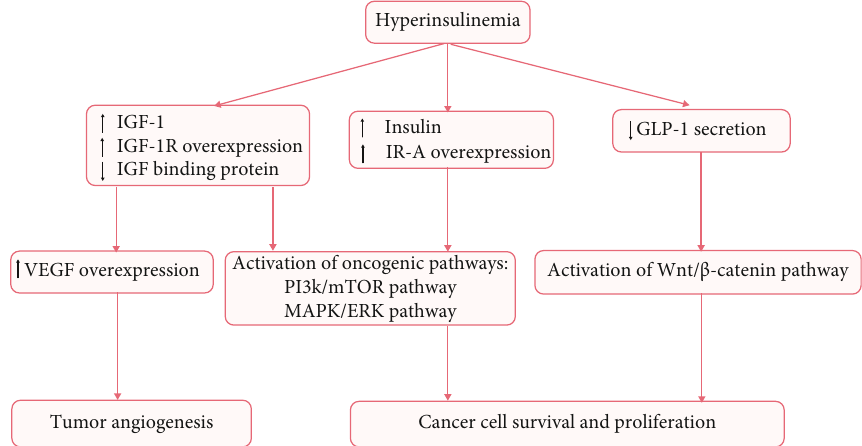
Figure 2: E ff ects of hyperinsulinemia and IGF axis on colorectal carcinogenesis. GLP-1: glucagon-like peptide-1; PI3K: phosphatidylinositol 3-kinase; mTOR: mammalian target of rapamycin; MAPK: mitogen-activated protein kinase; MEK: mitogen-activated protein kinase; ERK: extracellular signal-regulated